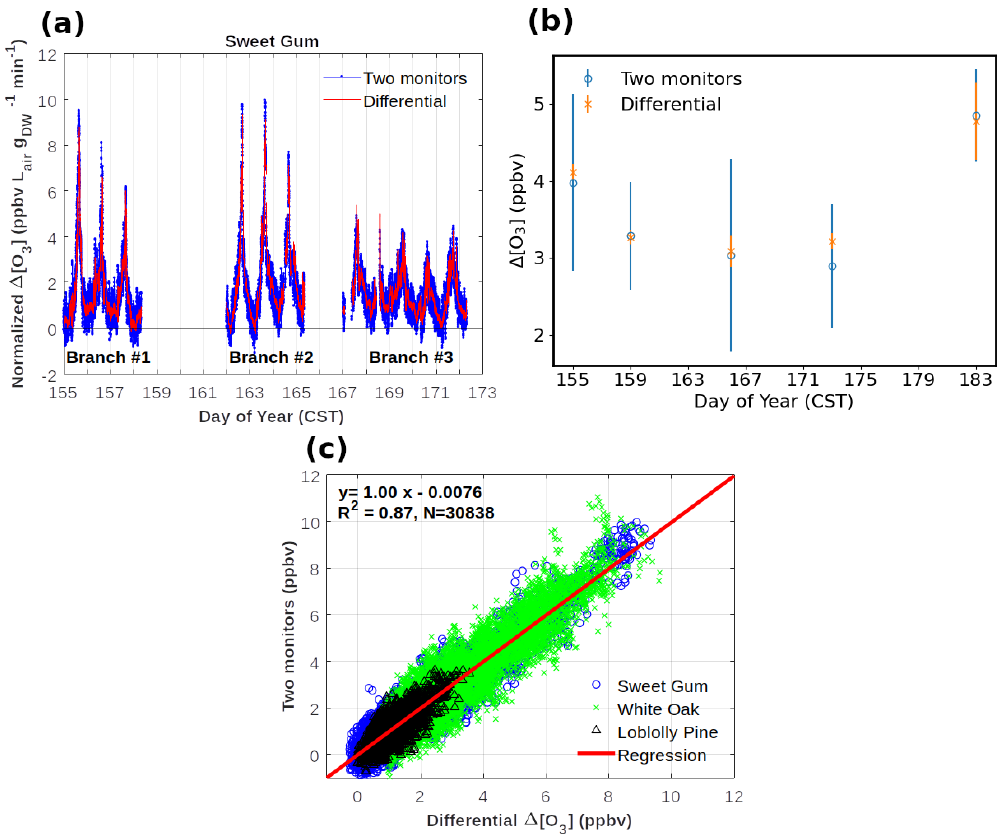
Figure 6. Results from comparisons of monitoring the ozone loss in the reactor with two monitors versus measuring the ozone differential directly with the configuration shown in Fig. 5. (a) Three multi-day experiments of (cid:49) [ O 3 ] monitoring from an enclosure of sweetgum branches. Data are also corrected for the empty bag OWL data shown in panel (b) and normalized for flow through the enclosure and dried weight of leaf biomass. (b) (cid:49) [ O 3 ] determinations from blank experiments on an empty enclosure. (c) Summary results of experiments on a total of three different vegetation species. All field experiment results are from the Southern Oxidant and Aerosol Study (SOAS) campaign between June and July 2013 at a field site in Perry County, western central Alabama (Praplan et al.,